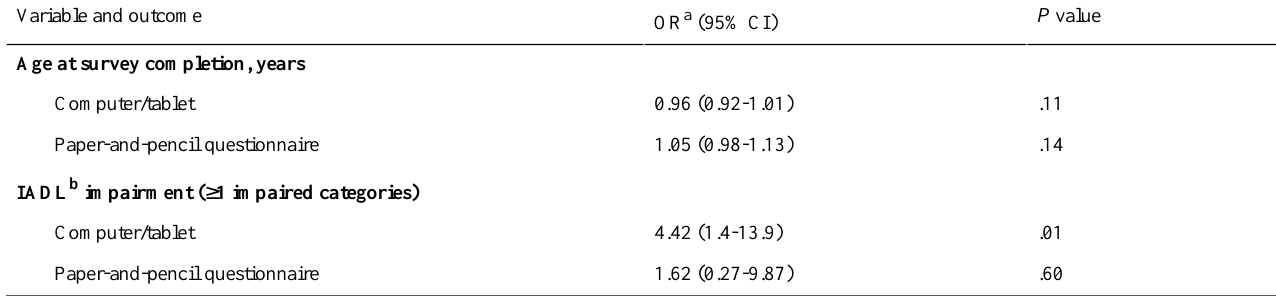
P valueOR a (95% CI)Variable and outcome